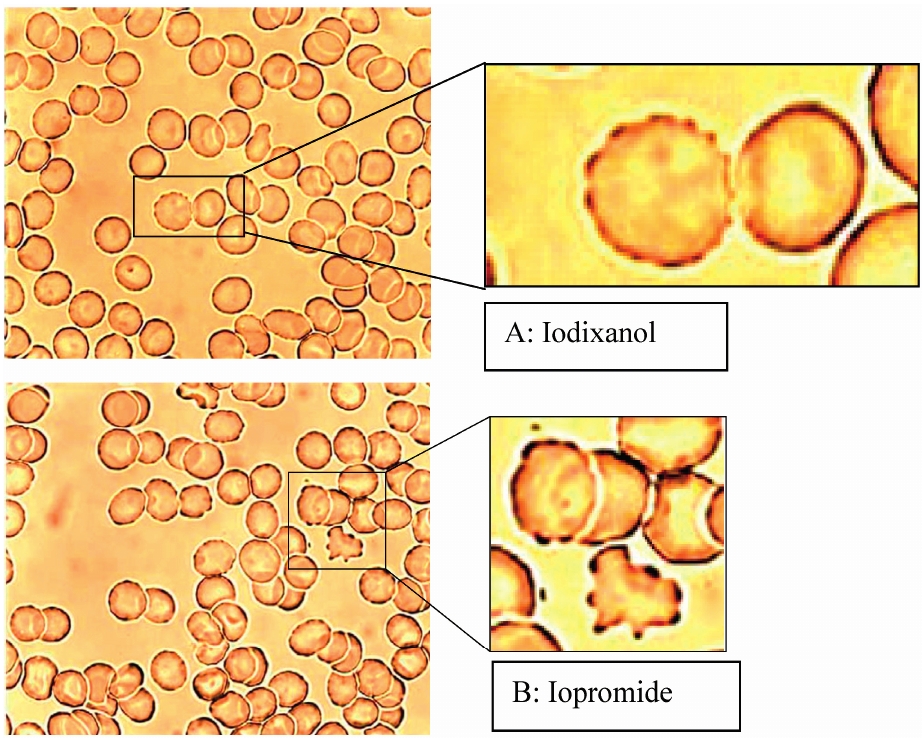
Figure 2. Erythrocytes in an Iodixanol/plasma mixture ( A ) or Iopromide/plasma mixture ( B ) 40% v / v each after resuspension in autologous RCM-free plasma (modified according to reference [6], Copyright 2008, with permission from IOS